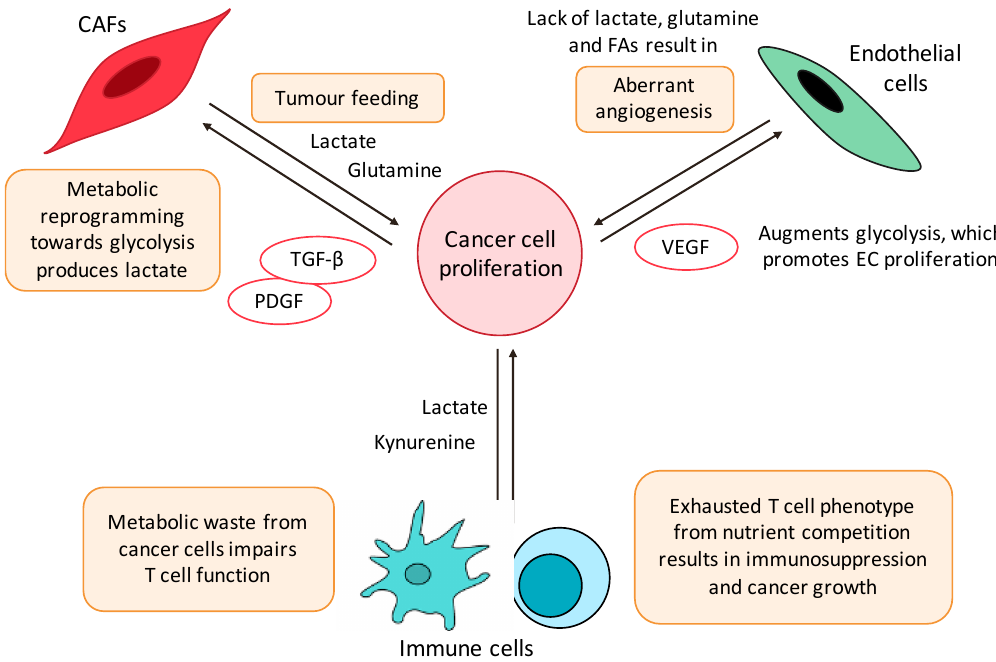
Figure 2. Key players of the metabolic crosstalk in the TME. Key players involved in the extensive, bidirectional crosstalk between tumour cells and the TME include CAFs, ECs, and immune cells. Tumours release factors such as PDGF and TGF- β , causing metabolic reprogramming in CAFs towards aerobic glycolysis, releasing energetic substrates such as lactate into the TME in a phenomenon known as ‘tumour-feeding.’ Meanwhile, tumour depletion of lactate, glutamine, and FAs in the TME lead to EC aberrant angiogenesis, which promotes proliferation and metastasis. VEGF is also released by tumours to promote EC proliferation. Tumour cells also induce metabolic changes to immune cells and cause immunosuppression. This is due to metabolic competition between immune cells and tumours for the same nutrients, producing an ‘exhausted’ T cell phenotype. Metabolic wastes, including lactate and kynurenine, are also released and impair T cell function, causing polarisation towards pro-tumorigenic T cell subtypes.